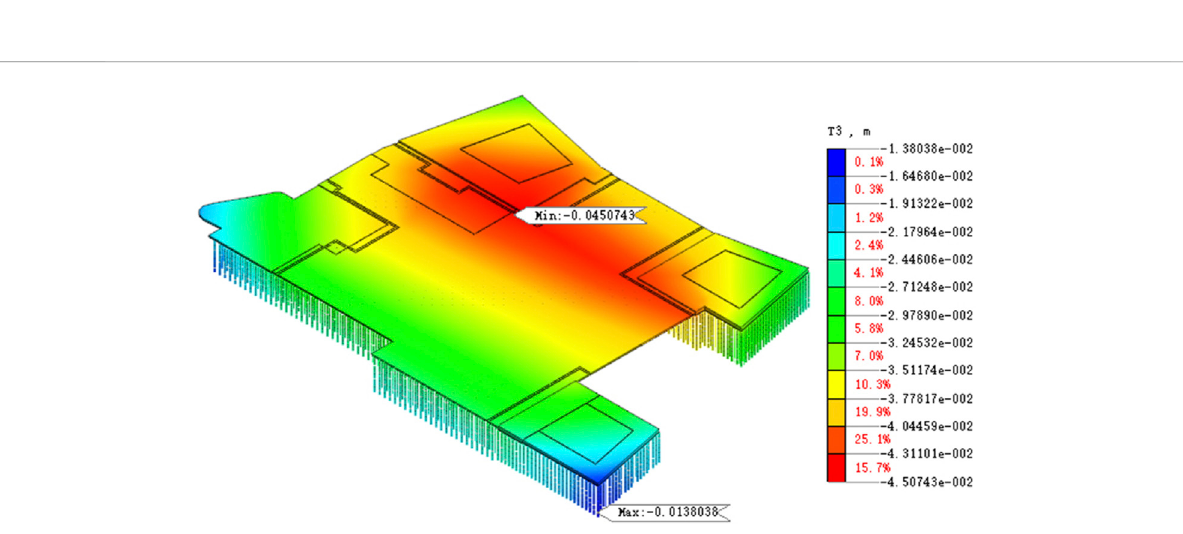
FIGURE 5 Contour diagram of overall settlement calculation in preliminary foundation